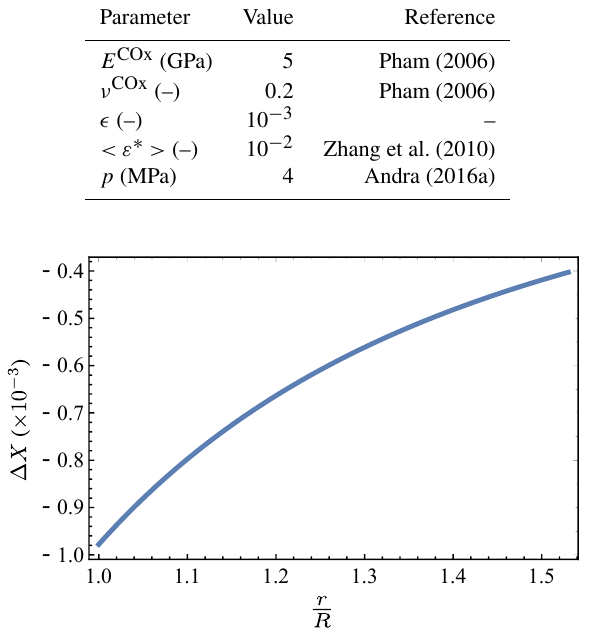
Figure 4. Crack closure as a function of the distance from the drift wall for problem